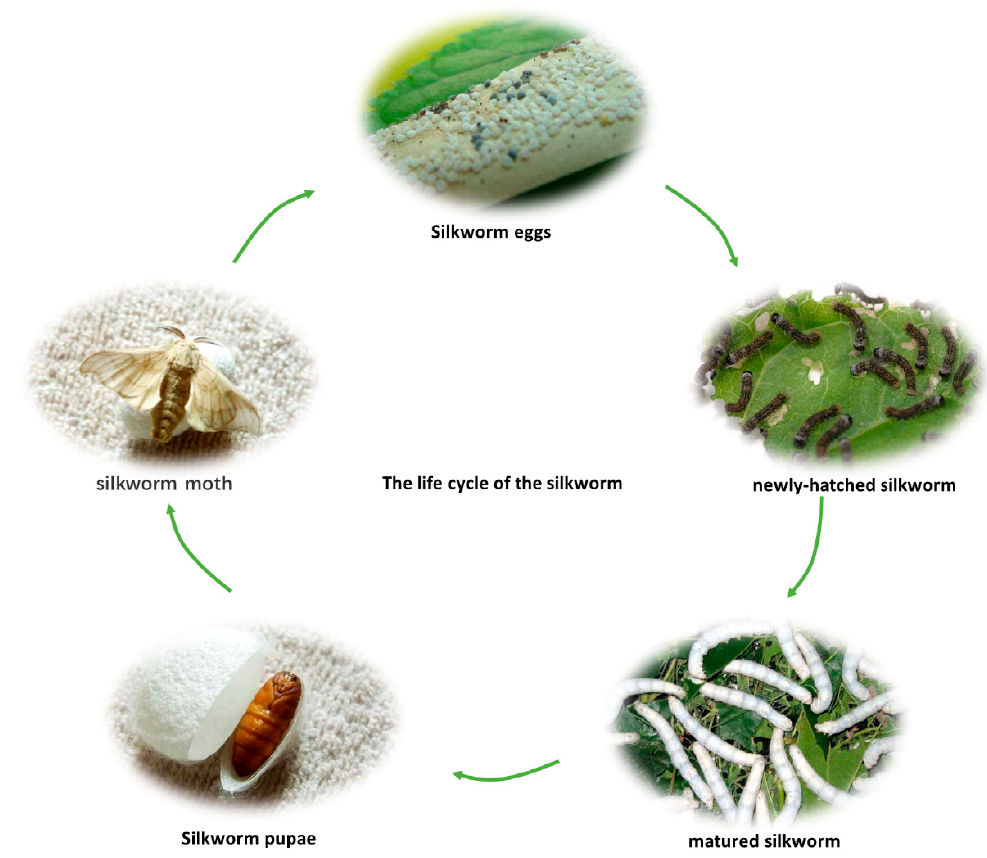
Figure 1. The life cycle of the